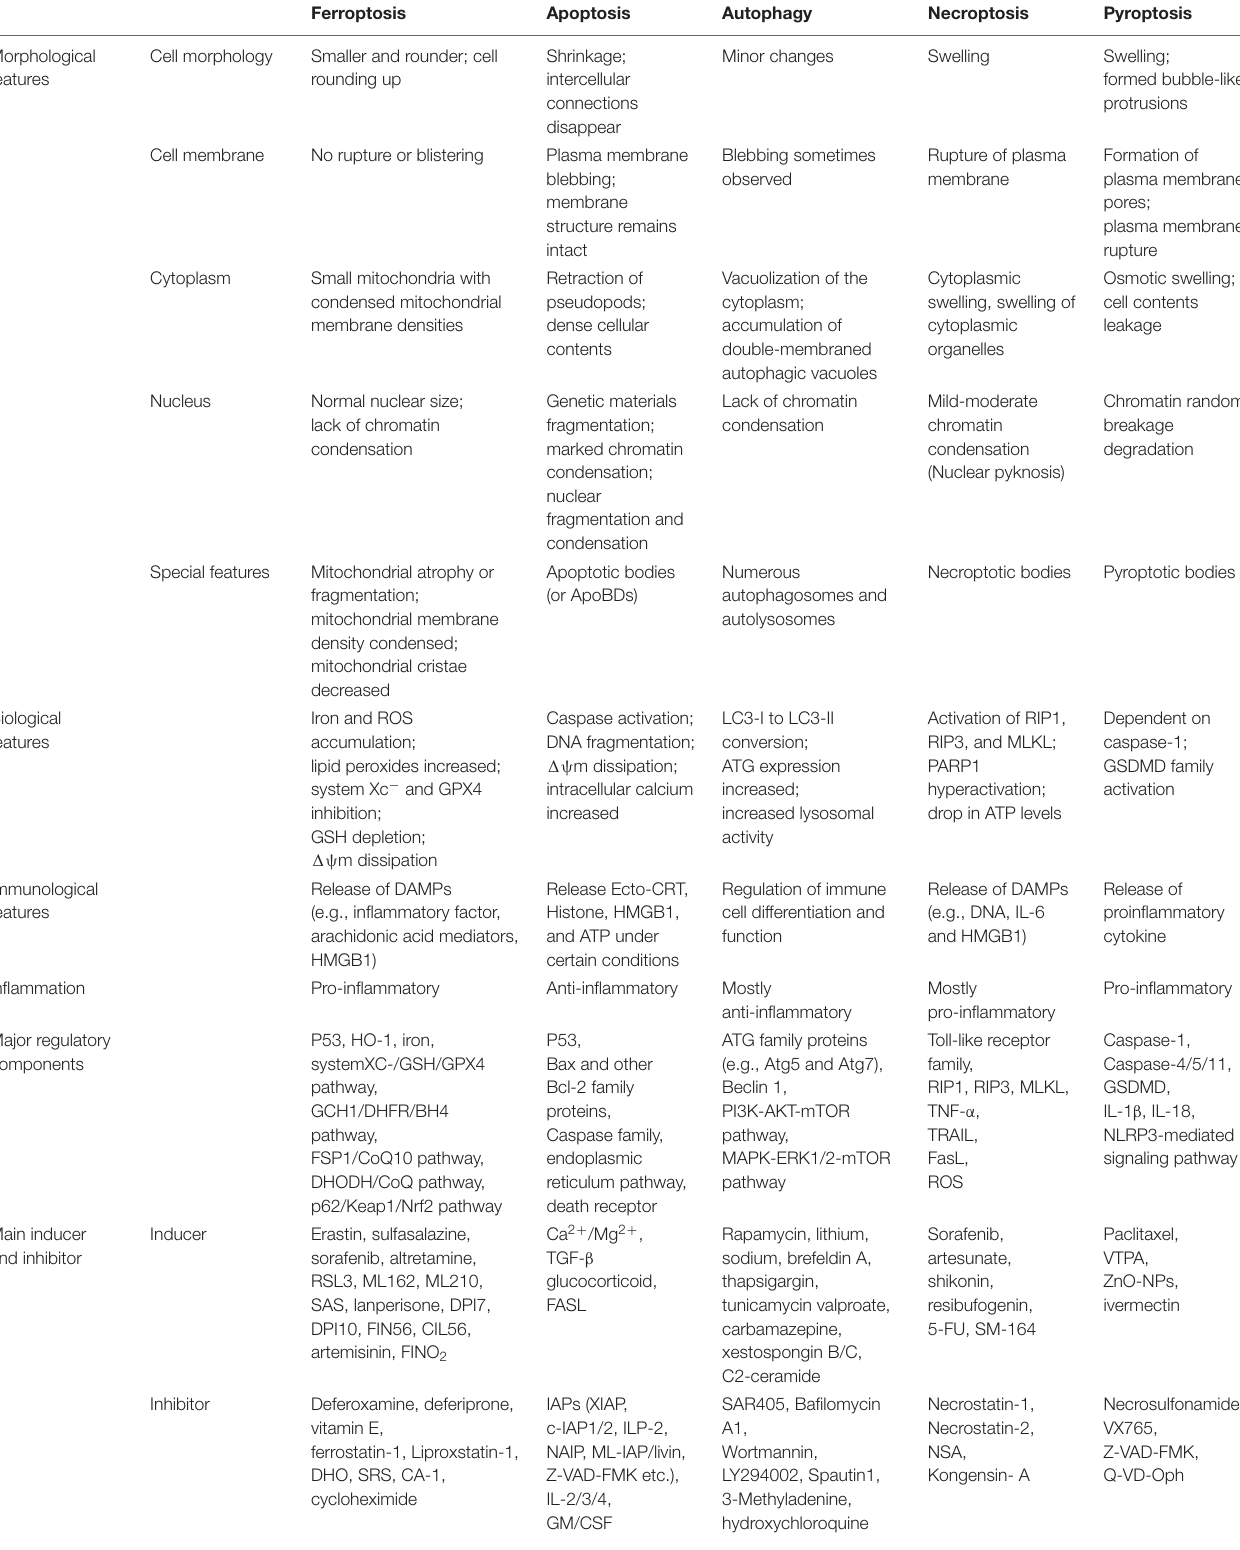
TABLE 1 | The main features of ferroptosis, apoptosis, autophagy, necroptosis, and